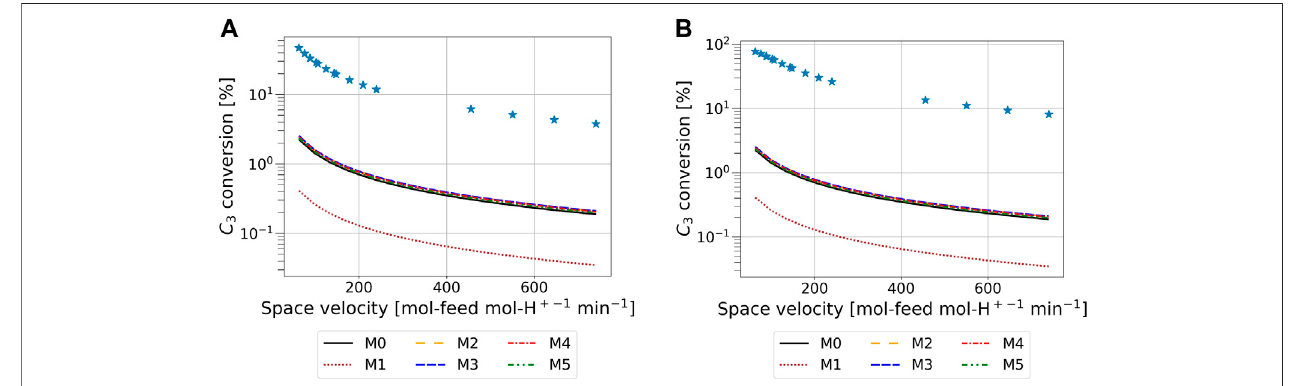
FIGURE 4 | Propylene conversion from M0 to M5 with respect to space velocity at constant pressure (2.18 atm) and temperatures 483 K (A) and 522 K (B) . The blue stars represent the MK model simulation data. The solid and dashed lines represent the reparameterized ROK model simulations. The lines for models M0 and M2 to M5 overlap each